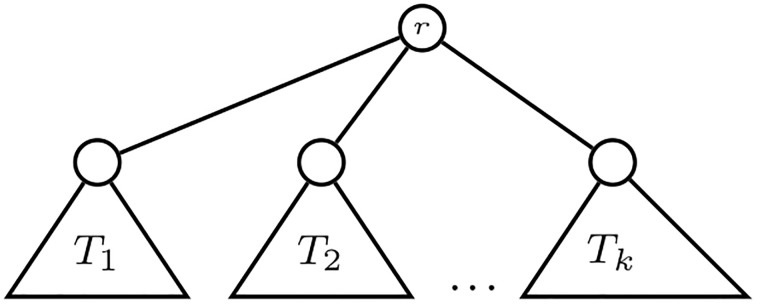
The (phylogenetic) tree T1 ⋆ ⋯ ⋆Tk.